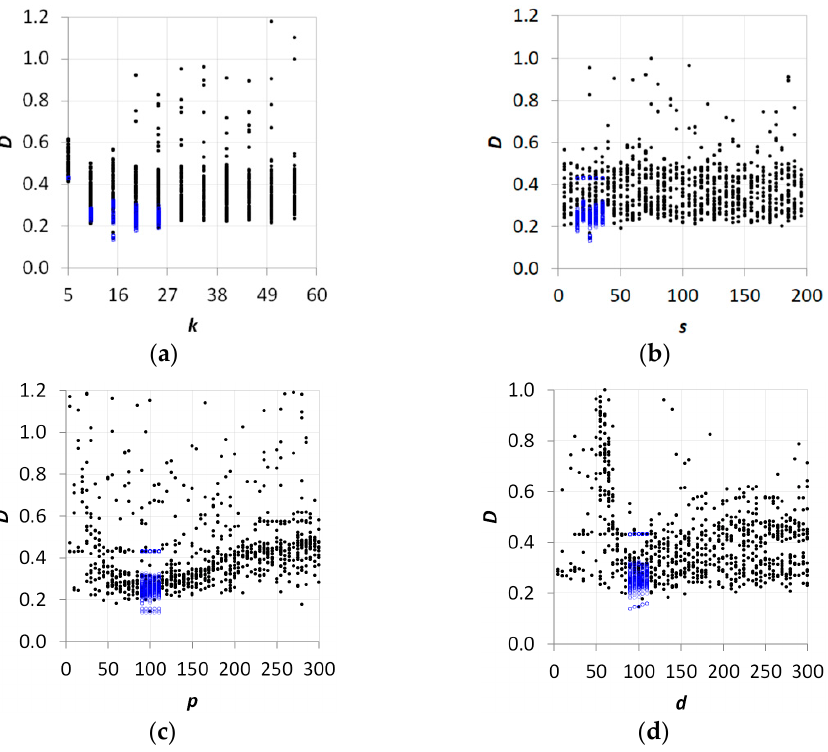
( d ) Figure 6. Segmentation parameters optimized on reference areas in the temperate period: ( a ) D versus k ; ( b ) D versus p ; ( c ) D versus s; ( d ) D versus d , dispersions. The best quadruple of parameters after the two iterations characterized the best matching between the areas of the segments with the areas of the reference lakes. The best quadruple of parameters allowed achieving D A ≅ 0.14 for the arid and D A ≅ 0.22 for the temperate (Table 1) periods; the ranges of the variability of the parameters explored through the two iterations are also shown between square brackets.